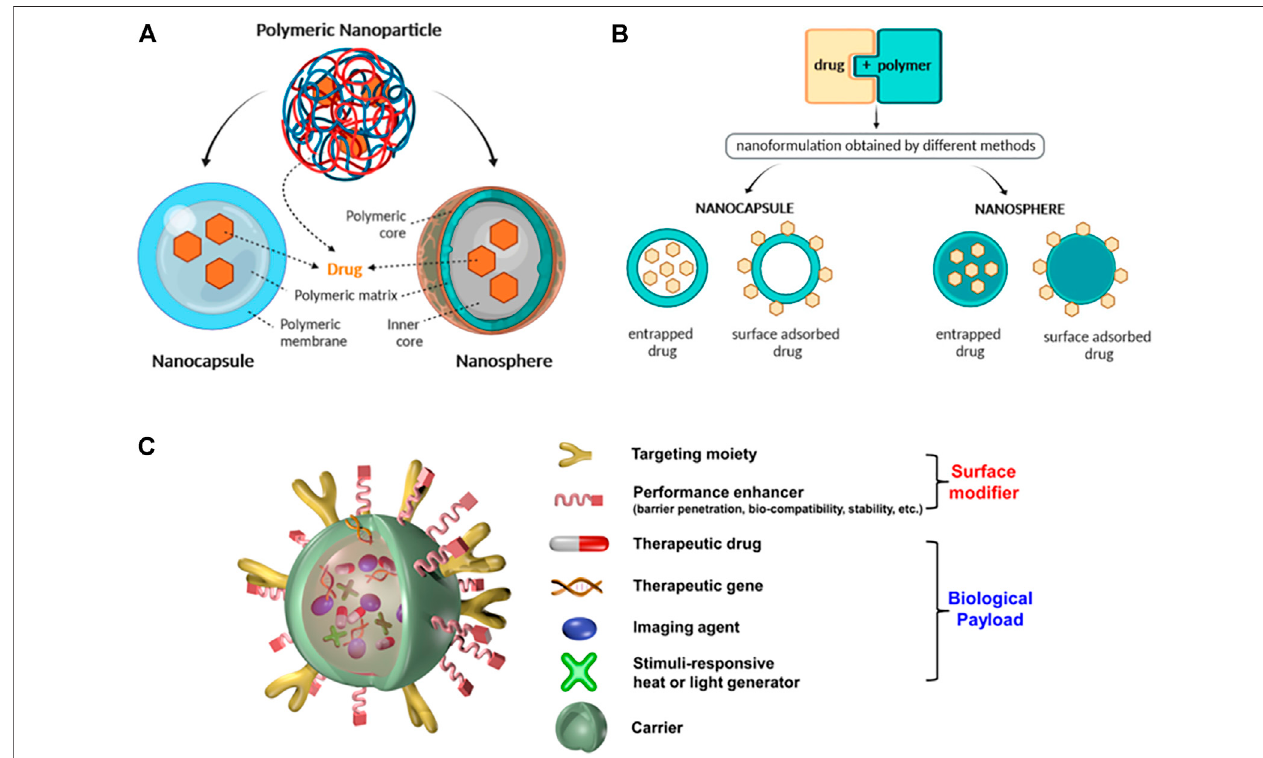
FIGURE 1 | (A) Schematic illustration of the structure of nanocapsules and nanospheres. (B) Different modes of association of drugs with nanospheres and nanocapsules. [ (A,B) Reproduced from (Zieli ń ska et al., 2020) with permission from the Multidisciplinary Digital Publishing Institute]. (C) Schematic illustration of a multifunctional nanocomposite. Reproduced from (Lim et al., 2015) with permission from American Chemical Society.